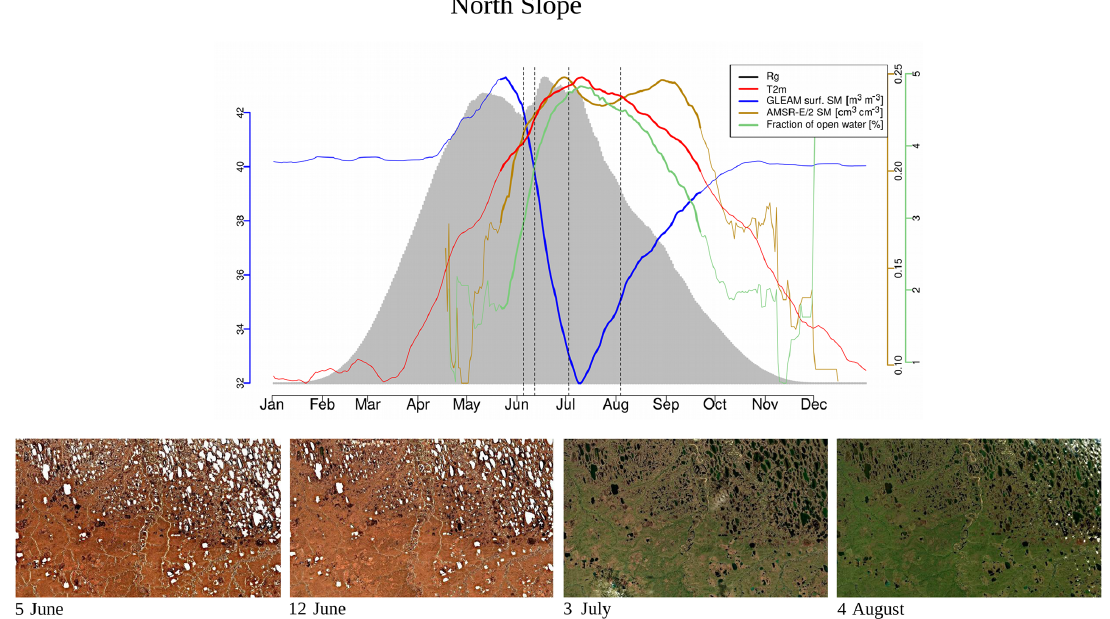
Figure 3. Climatologies of different atmospheric and land surface variables for a small area in the North Slope in Alaska, indicated in Fig. 1. Bold lines indicate the time period when air temperatures are above the freezing point (no axes displayed for temperature and incoming radiation). Vertical dashed lines indicate the time of the year when the Sentinel-2 images shown in the second panel were taken. Sentinel-2 images are atmospherically corrected and taken in